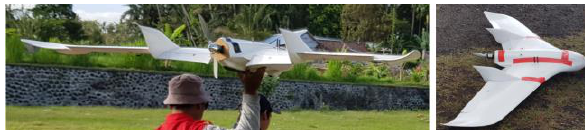
Figure 1. UAV Fixed wing, Buffalo FX-79 with 2,000mm wingspan length, 1,270mm fuselage length, flying weight 5000gr, flight speed 70km/hours and 100km flight distance.